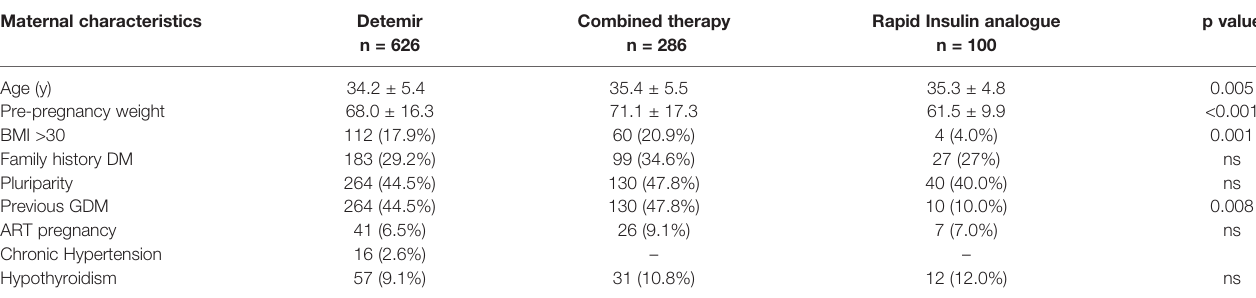
TABLE 4 | Maternal characteristics, including anthropometric data, family and clinical history, of women with GDM treated with long-acting analogues (Detemir) or rapid analogues or combined therapy. Maternal characteristics